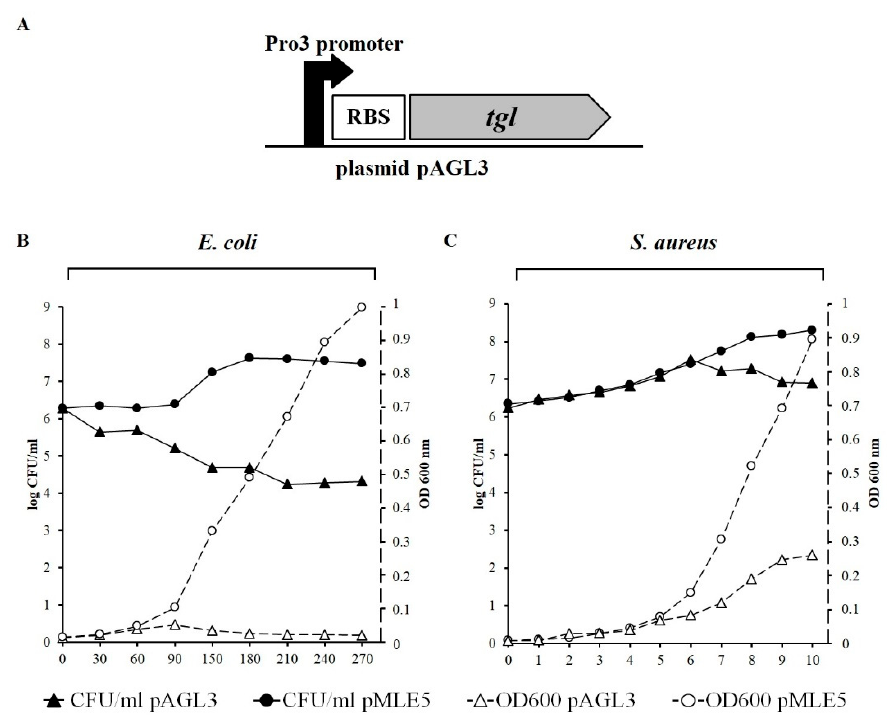
Figure 3. Influence of intracellular Tgl protein on growth and survivability of E. coli DH5 α and S. aureus RN4220 cells. ( A ) Schematic picture of tgl expression cassette in pAGL3 plasmid. ( B , C ) Changes in optical density (dotted lines) and number of colony forming units (solid lines) in cultures of E. coli DH5 α ( B ) and S. aureus RN4220 ( C ) cells harboring pAGL3 or pMLE5 plasmid (empty control vector). At zero time, the diluted overnight culture of each strain (1:100; OD 600 of about 0.001) was transferred to 42 ◦ C to derepress transcription from the Pro3 promoter. Left y-axis of each graph represents the log of CFU / mL, right y-axis represents OD 600 . Each curve shows representative results of one of three independent experiments.